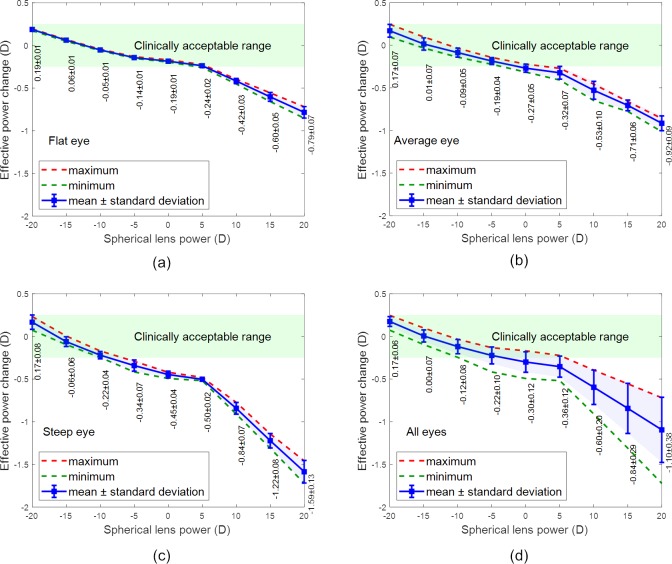
Effective power change in spherical lenses where the x-axis reports the spherical power of the contact lens when fitted to (a) a flat eye, (b) an average eye, (c) a steep eye and (d) all eyes.